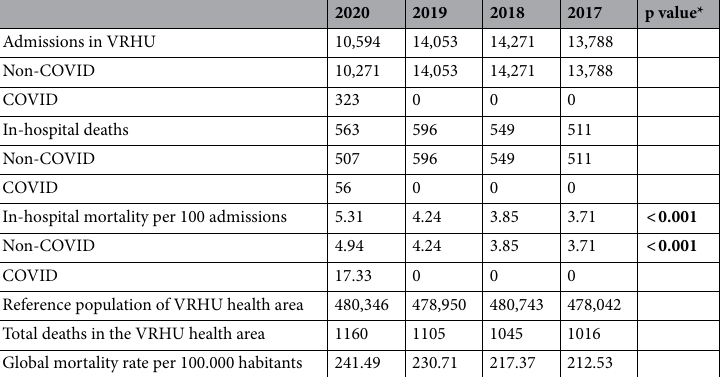
Table 2. In-hospital and global mortality at the Virgen del Rocío health area between February 27 and June 7, 2020 (sub-period 1: first COVID-19 pandemic wave in Seville), compared with the same period in 2017–19. *Chi square test. Significant values are in